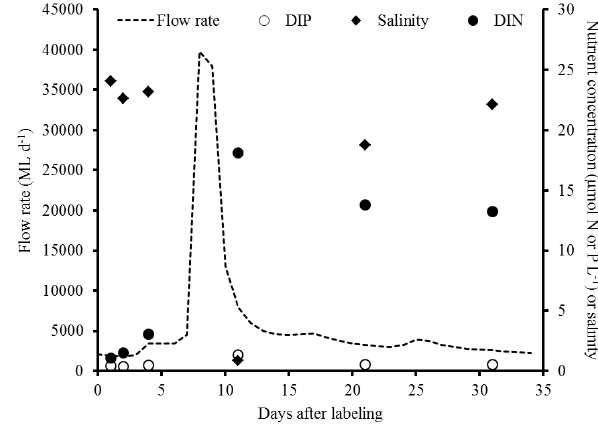
Fig. 1. Variations in flow rate of the Richmond River and variations in salinity, dissolved inorganic nitrogen concentration (DIN), and dissolved inorganic phosphorus concentration (DIP) at the study site during the study